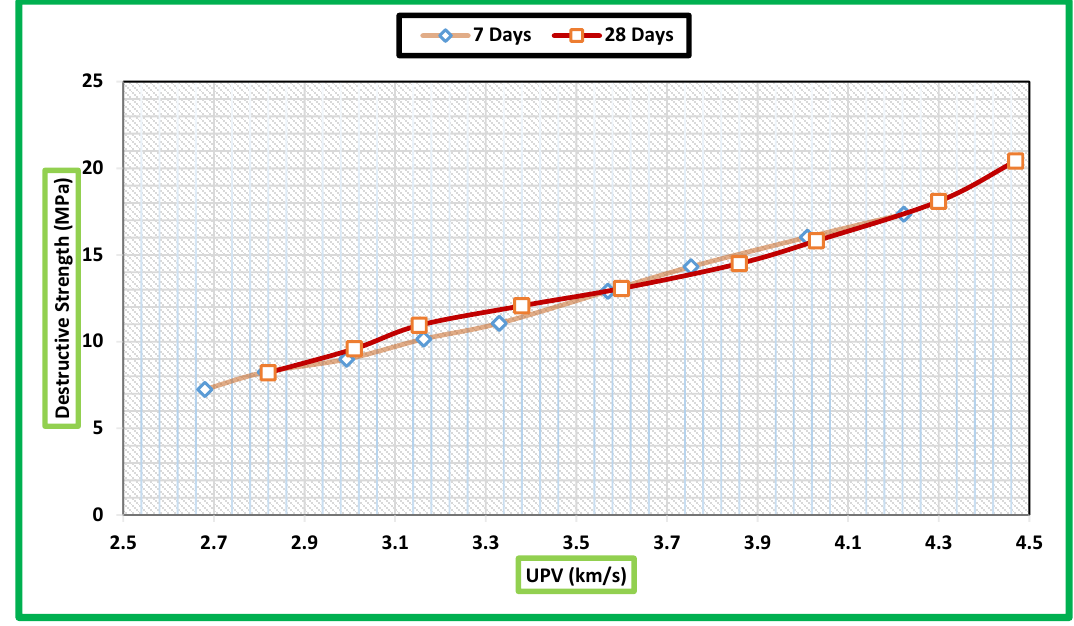
Figure 20. The relationship between velocity (UPV) and destructive strength (MPa).